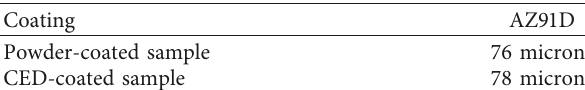
Table 2: Thickness of